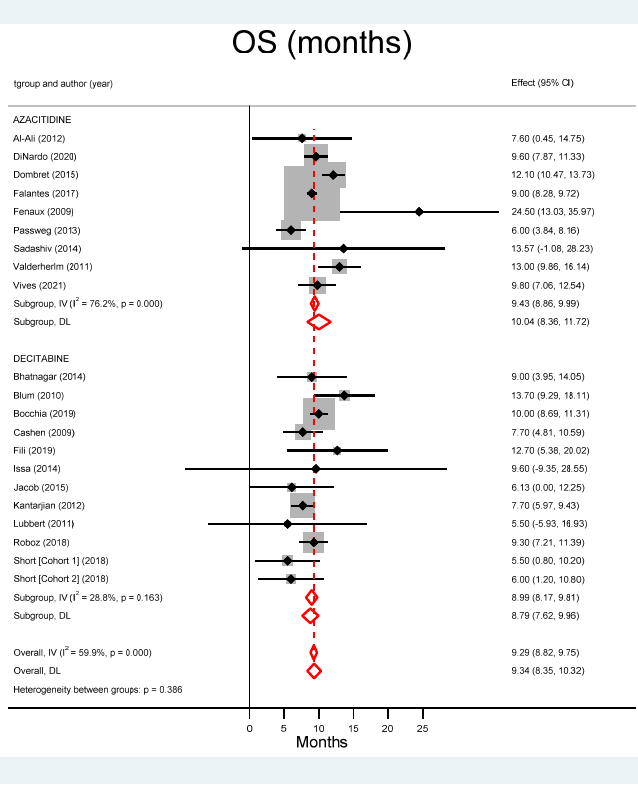
Figure 4. Pooled analysis of overall survival (OS).